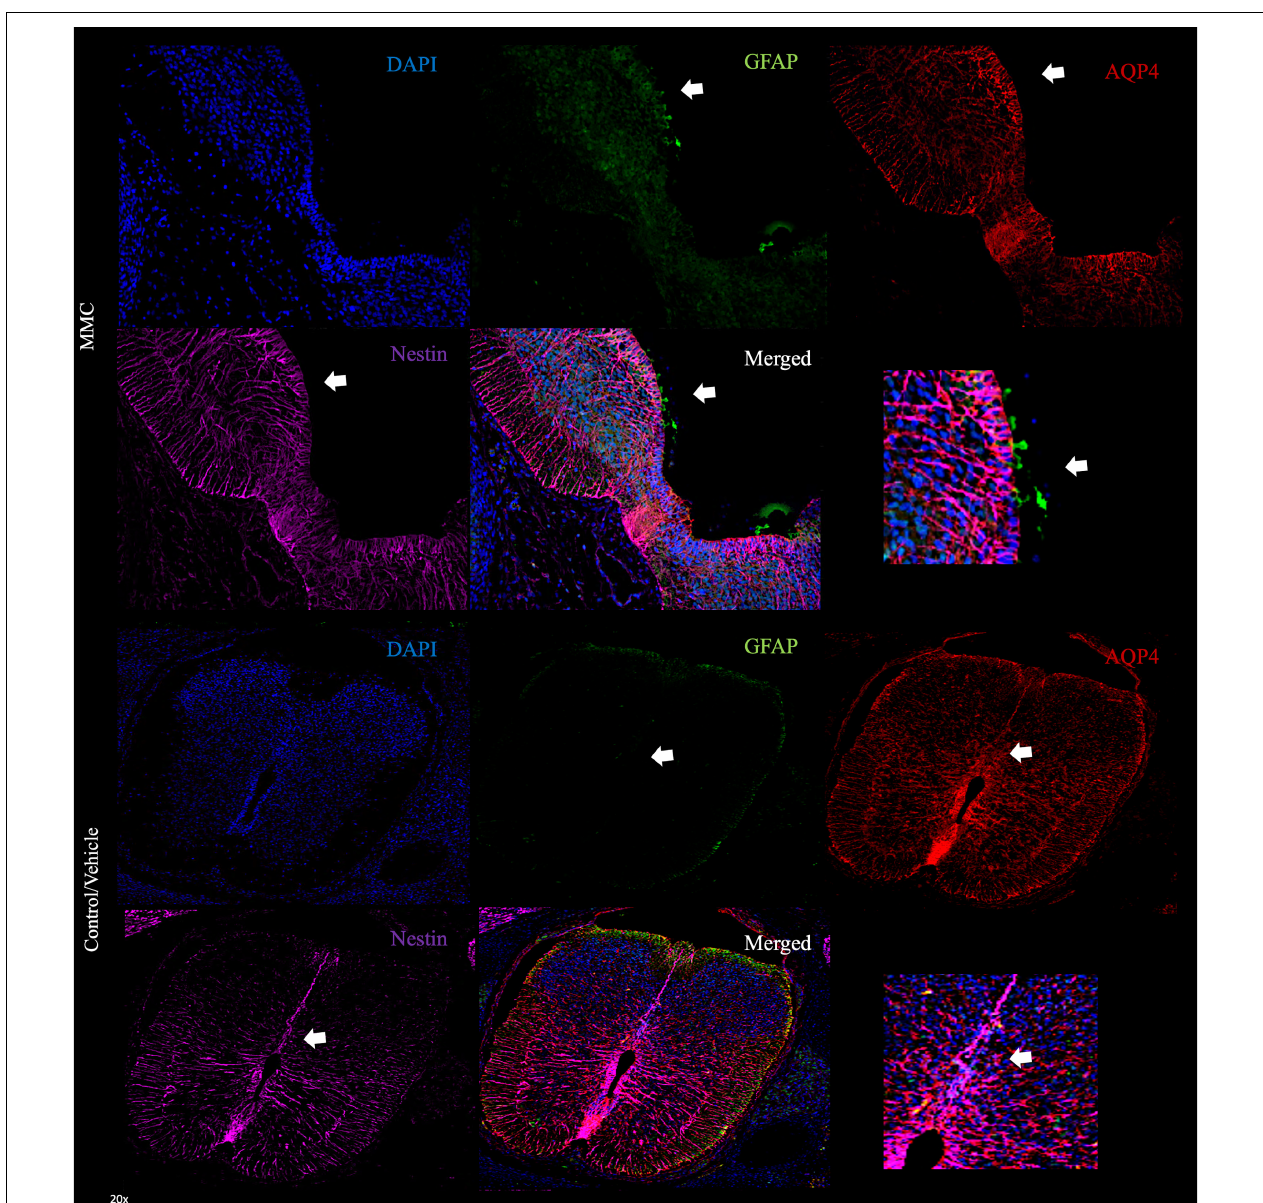
FIGURE 4 | Aquaporin 4 astrocytes in ventricular zone spina bifida fetuses. Generation of mature astrocytes in MMC compared with control spinal cords at E17. AQP4+ GFAP+ cells located in the VZ exposed to the amniotic fluid in spina bifida at E17 (20 × ). Magnification of VZ in MMC and control/vehicle animals